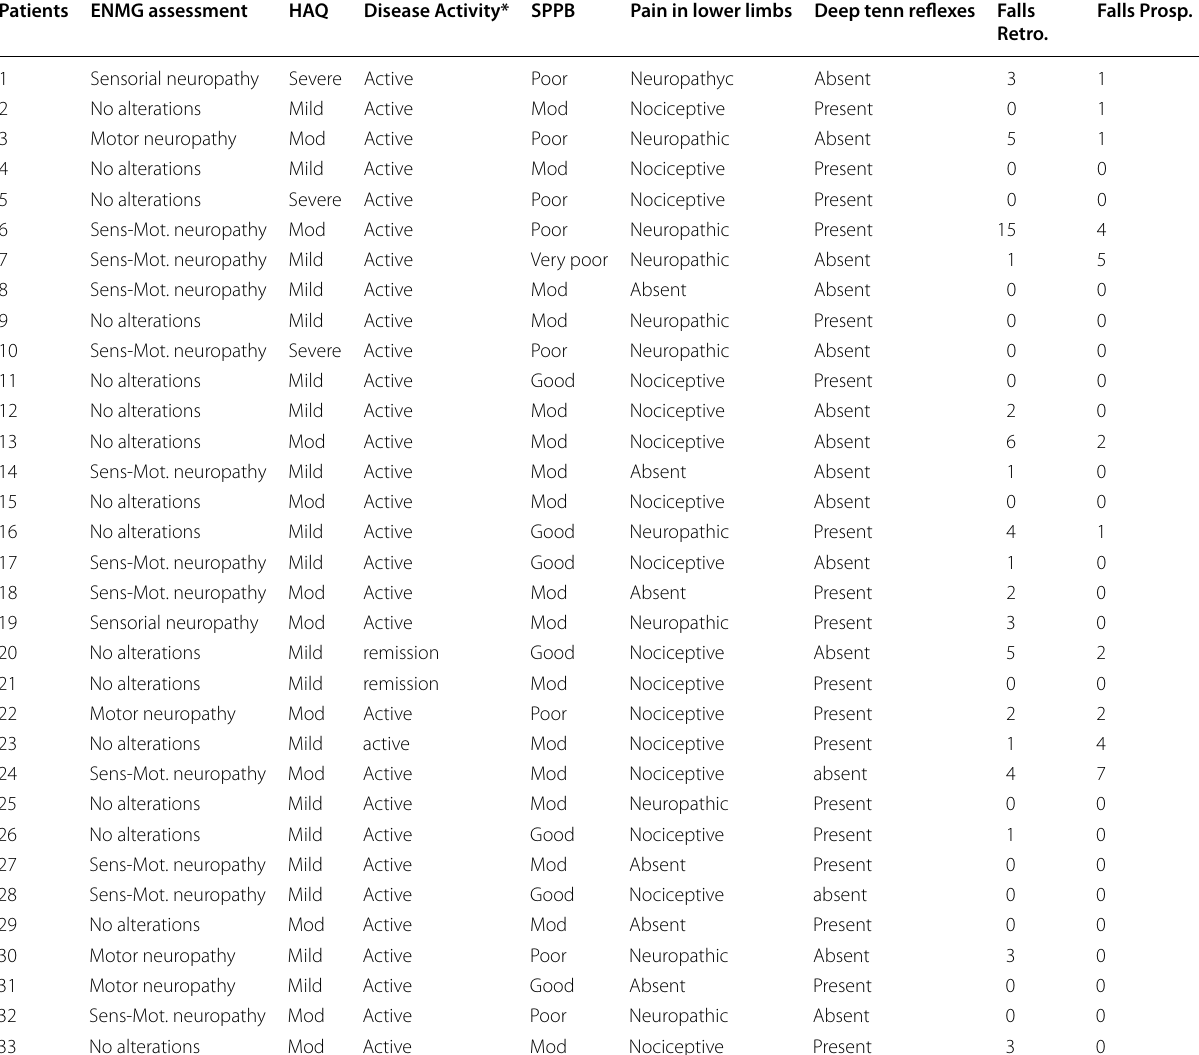
Table 4 Individual data collected Patients ENMG assessment HAQ Disease Activity* SPPB Pain in lower limbs Deep tenn reflexes Falls